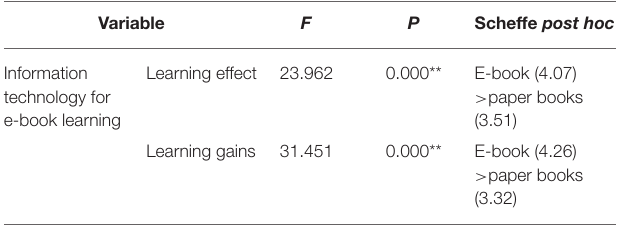
TABLE 2 | Difference analysis of using information technology for e-book learning in learning effectiveness.